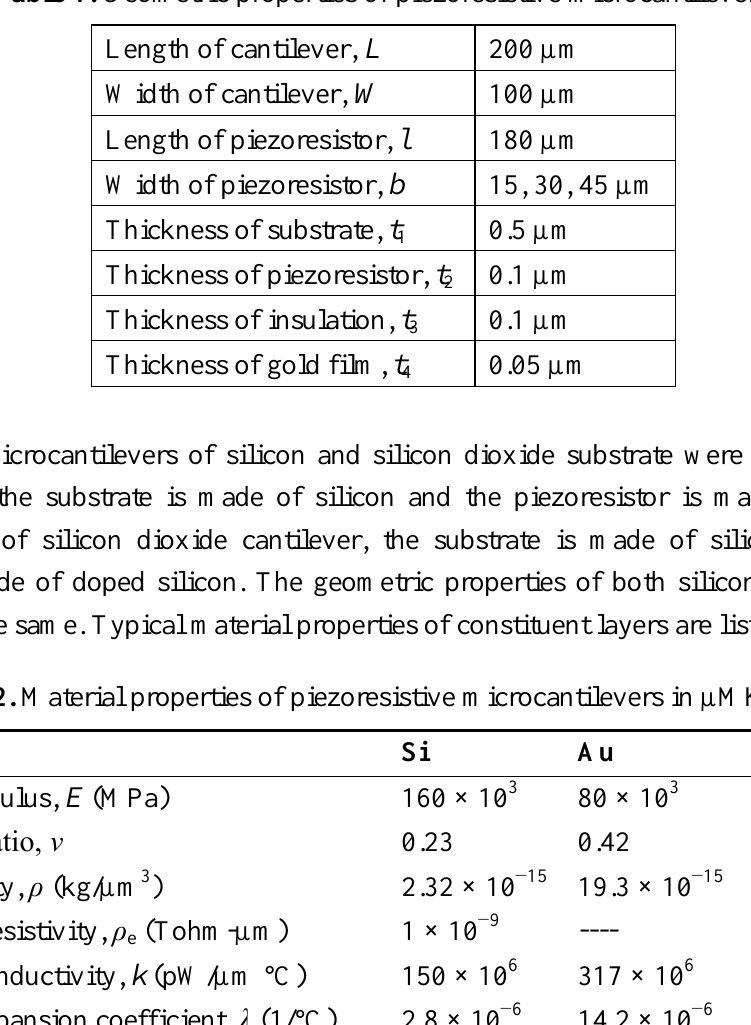
Table 1. Geometric properties of piezoresistive microcantilevers.